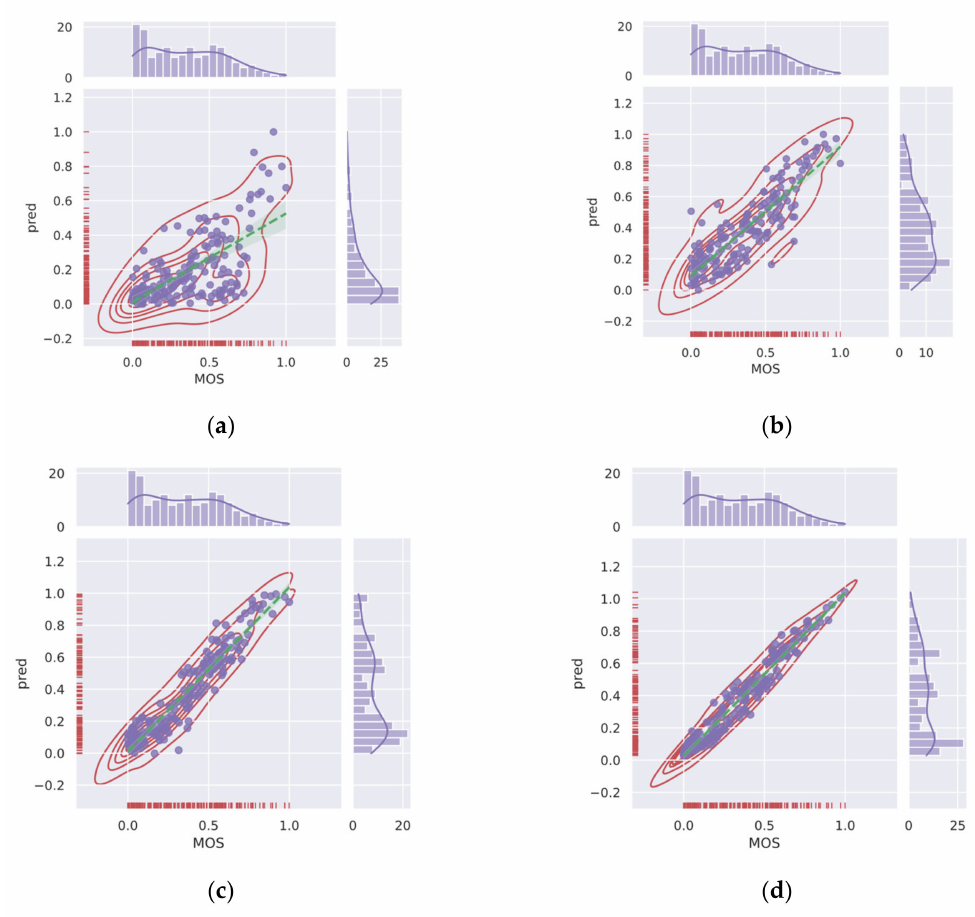
Figure 3. Representative traditional IQA methods and deep learning-based methods are compared with our proposed method on dataset TID2013. Higher correlation means better performance of